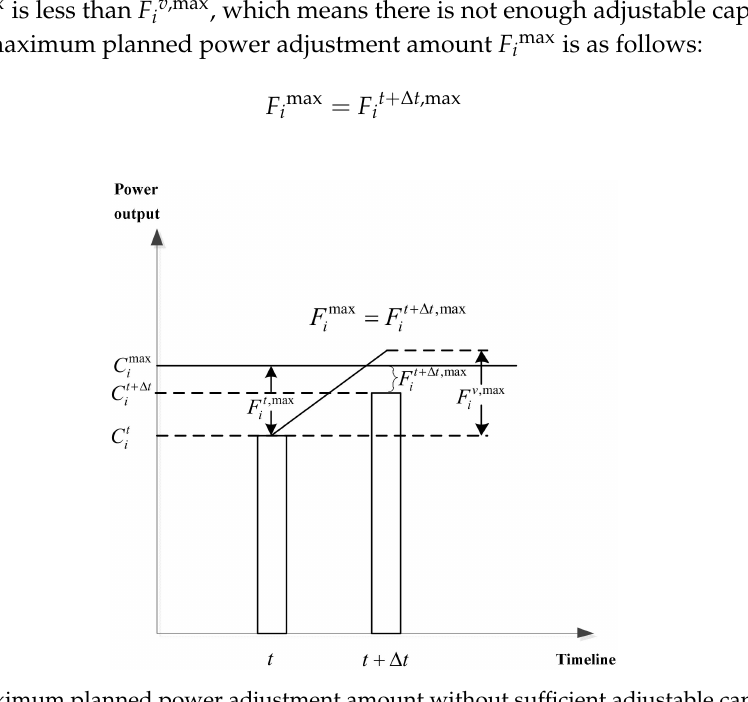
Figure 3. Maximum planned power adjustment amount without su ffi cient adjustable capacity when additional power supply is